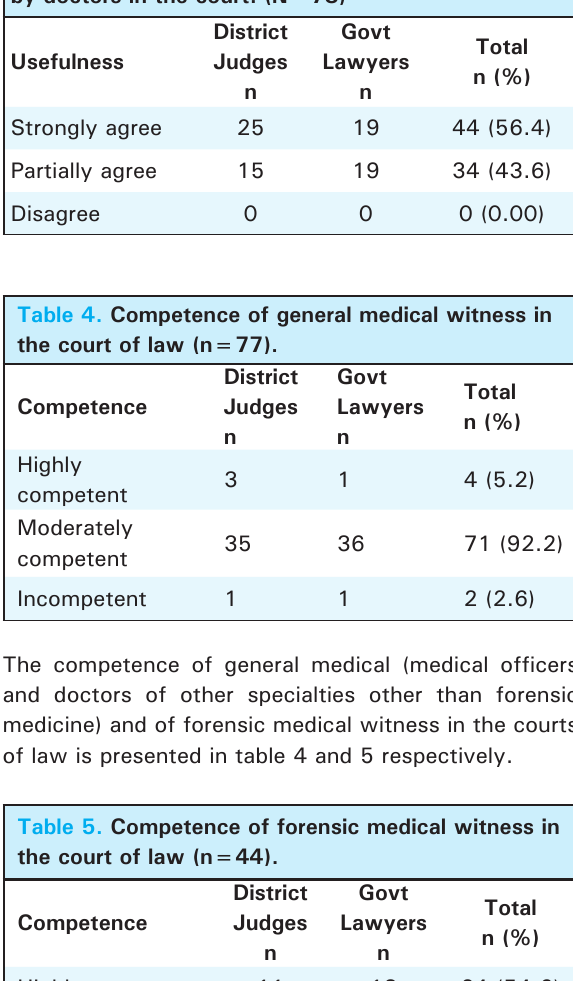
Table 3. Usefulness of oral testimony of the evidence